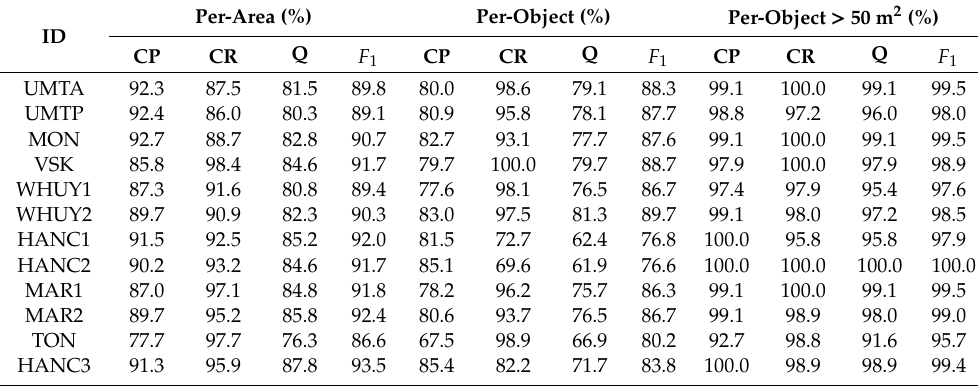
Table 2. Average evaluation results comparison of the building extraction (Area 1 to 3). (The best values per column are shown in the bold